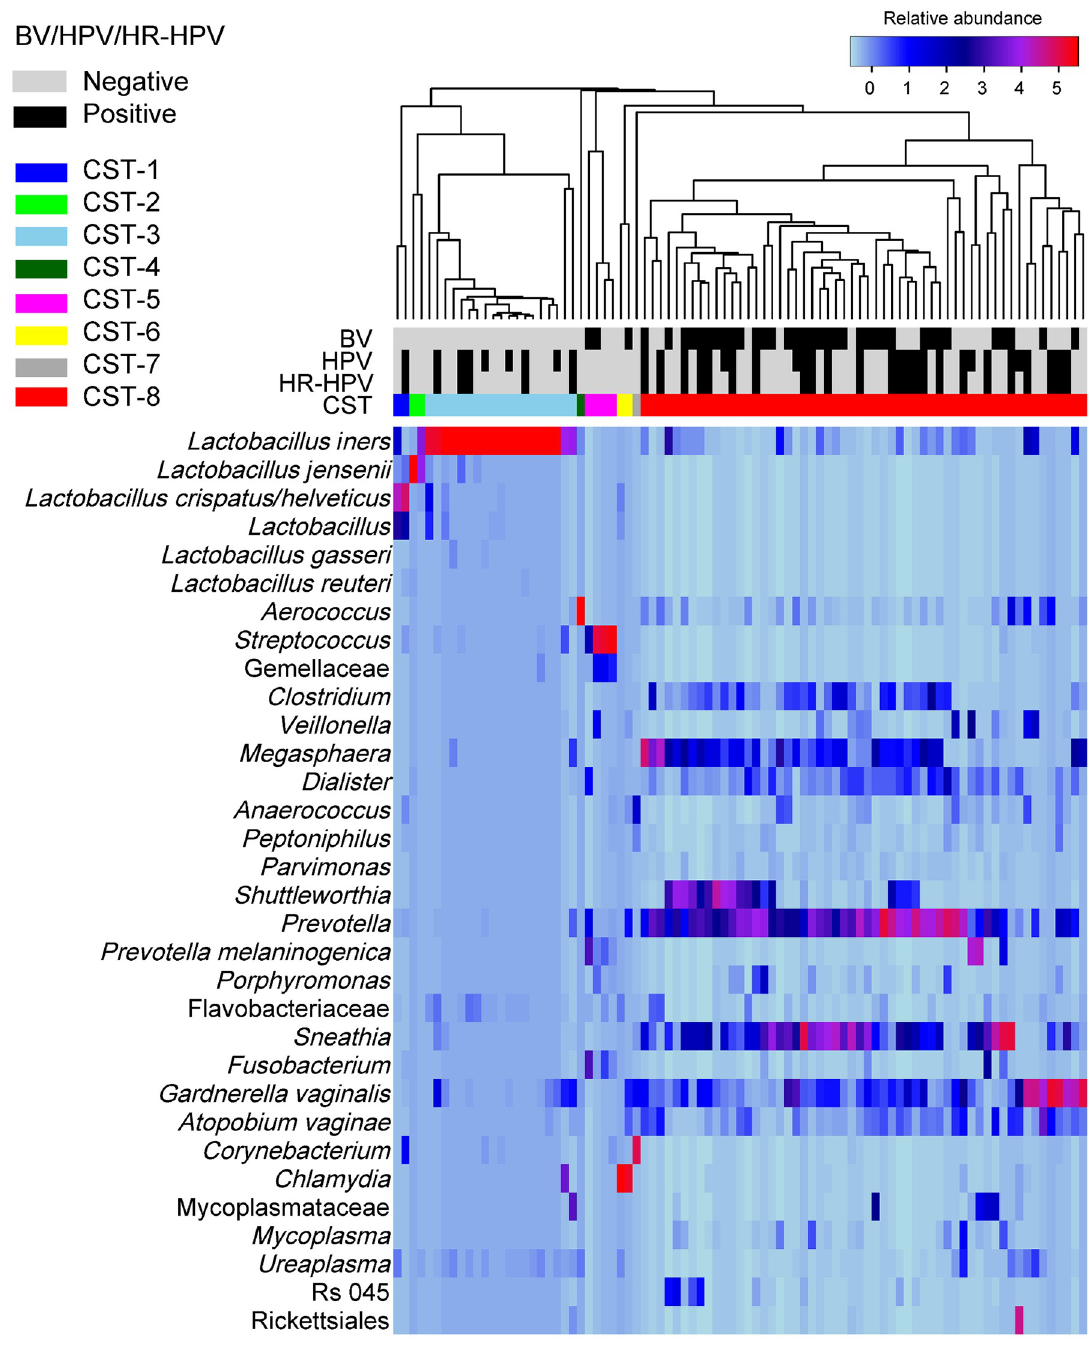
Fig 1. Average linkage hierarchical clustering of the cervicovaginal samples based on the composition and relative abundance of bacterial communities. The colour key of the relative abundances is indicated in the upper right corner. A scale towards blue (0) and red (5) indicates a lower and higher relative abundance, respectively. Rows represent the bacterial taxa whereas the columns represent the samples. All bacterial taxa with � 0.33% relative abundance are shown. All Lactobacillus spp., regardless of their relative abundances were included in the analysis. Bacterial vaginosis (BV), human papillomavirus (HPV) and high-risk (HR)-HPV infection status as well as the community state type are indicated. Eight microbiota clusters were detected based on Bray-Curtis index.